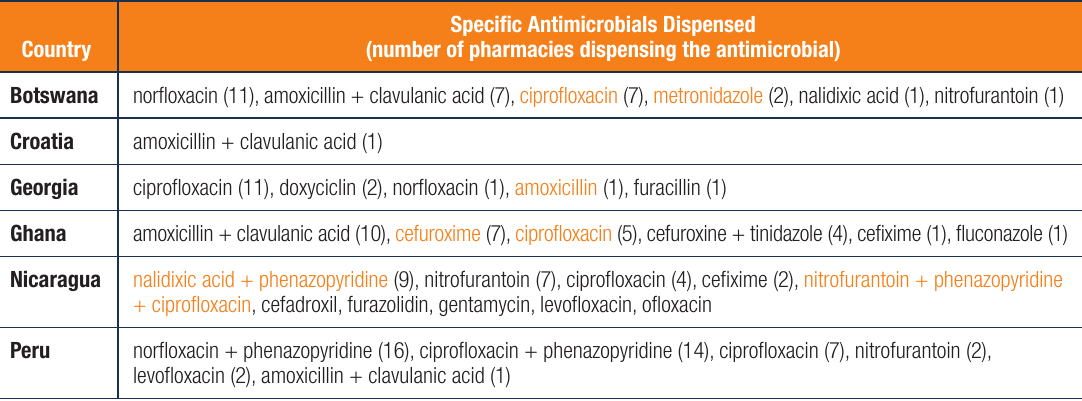
TABLE 5. Antimicrobials Dispensed without Prescription In orange, products with more brand names or irrational fixed-dose combinations, by country